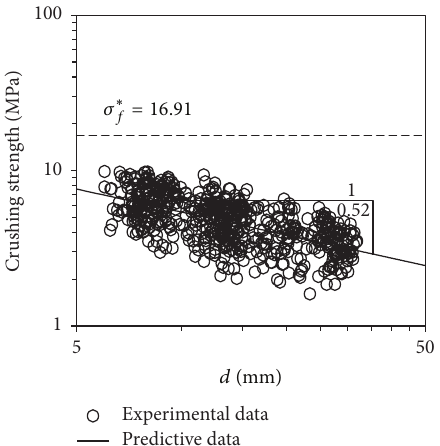
Figure 10: Relationship of probability of survival and crushing